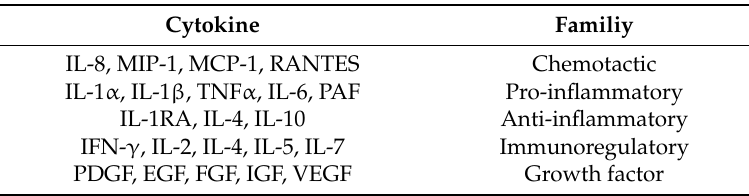
Table 1. Cytokines acting in atherosclerosis and oral